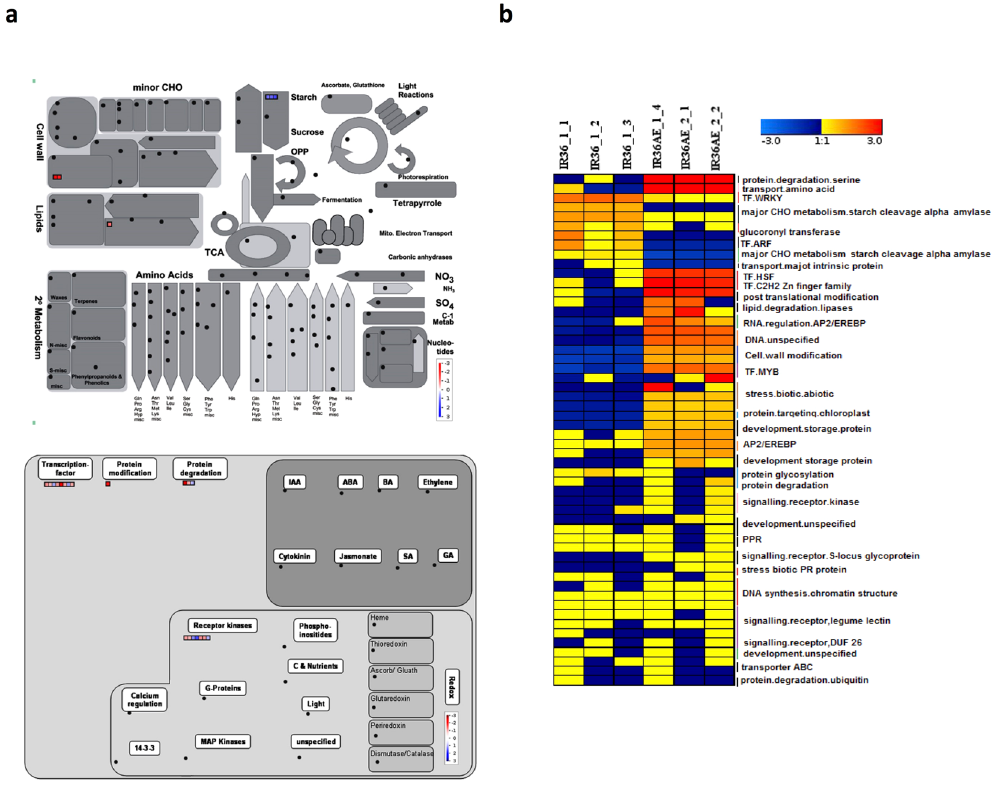
Figure 6. Transcriptomics analysis of intermediate vs. low GI lines. ( a ) MapMan overview of differences in metabolites between low and intermediate glycemic index varieties having the same genetic background and ( b ) heatmap showing differentially expressed